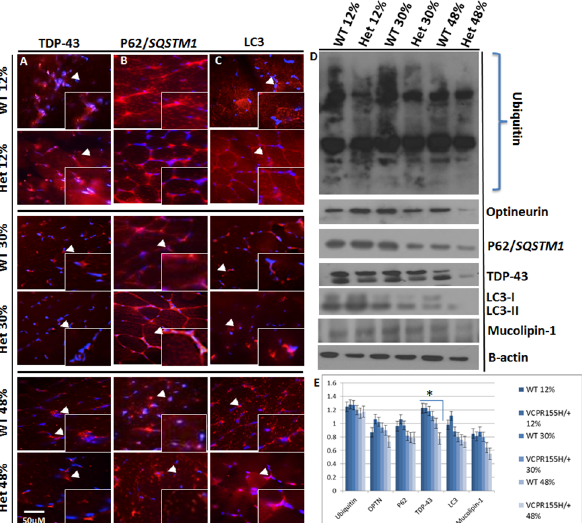
Fig 4. Autophagy influx in the quadriceps of WT and VCP R155H/+ mice on normal and different lipid- enriched diets. Immunohistochemical histological analyses comparing WT and heterozygote VCP R155H/+ knock-in animals on varying 12%, 30%, and 48% lipid-enriched diets stained with (A) TDP-43 (white arrows), (B) p62/ SQSTM1 , and (C) LC3-I/II. (D) Western blot of WT and heterozygote VCP R155H/+ knock-in animals on varying 12%, 30%, and 48% lipid-enriched diets analyzed for ubiquitin, optineurin, p62/ SQSTM1 , TDP-43, LC3-I/II, and Mucolipin (TRPML1). Magnified insets and white arrows indicate increased p62/SQSTM1 autophagic puncta, LC3 and TDP-43 protein expression translocated from the nucleus to the cytoplasm. (E) Densitometry analyses relative to loading control (Beta-actin). Statistical significance is denoted by * P (cid:1) 0.05. The number of mice analyzed per experiment is 8 –